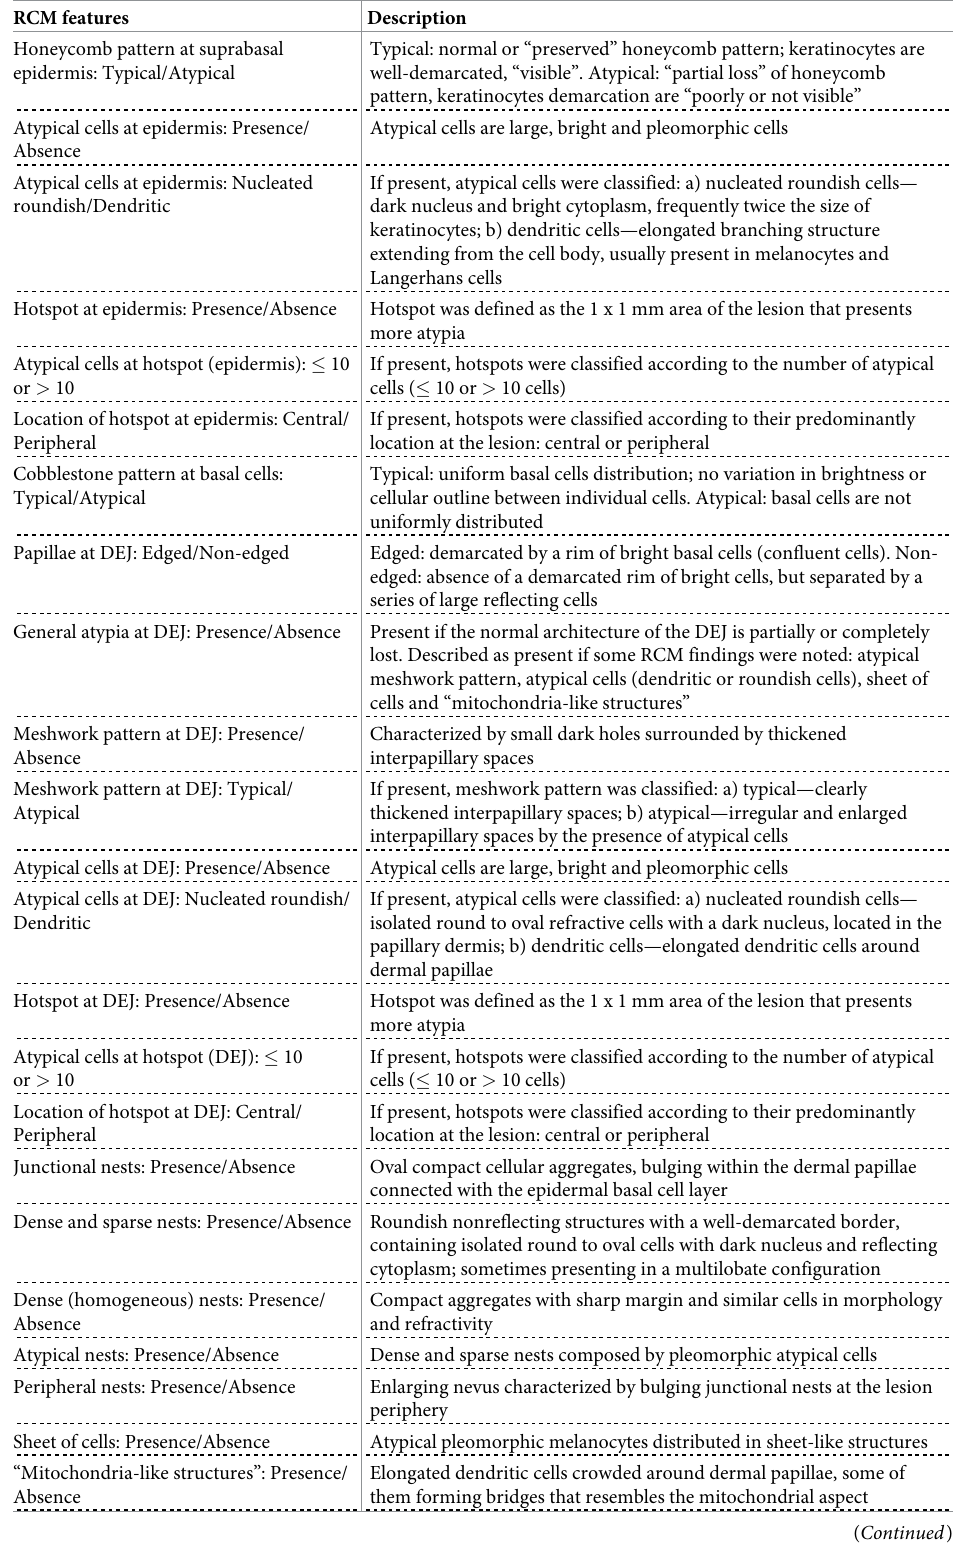
Table 1. Description of RCM